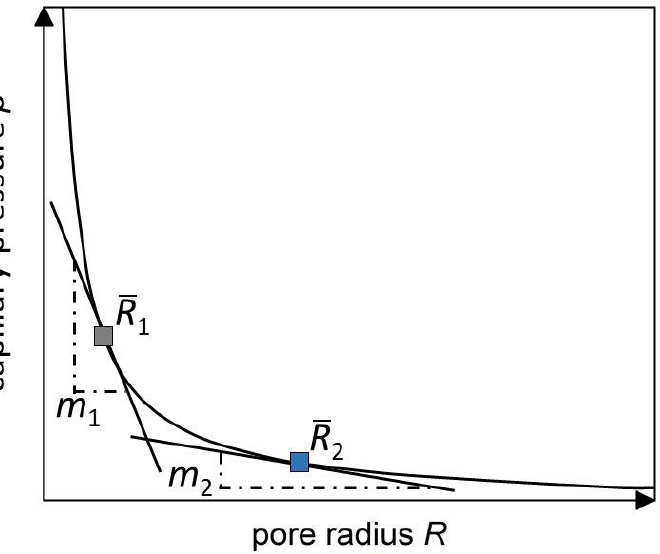
Figure 5. Schematic representation of the dependence of the capillary pressure on the pore radius with the weighting of the radii by the respective